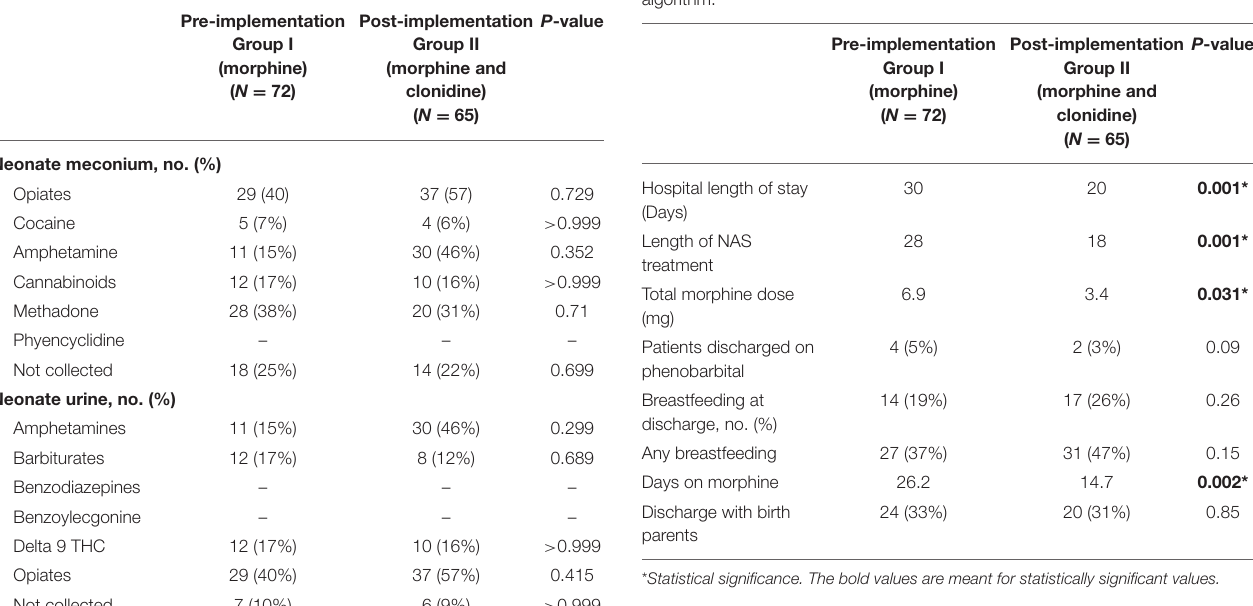
TABLE 2 | Neonatal urine and meconium toxicology profiles.